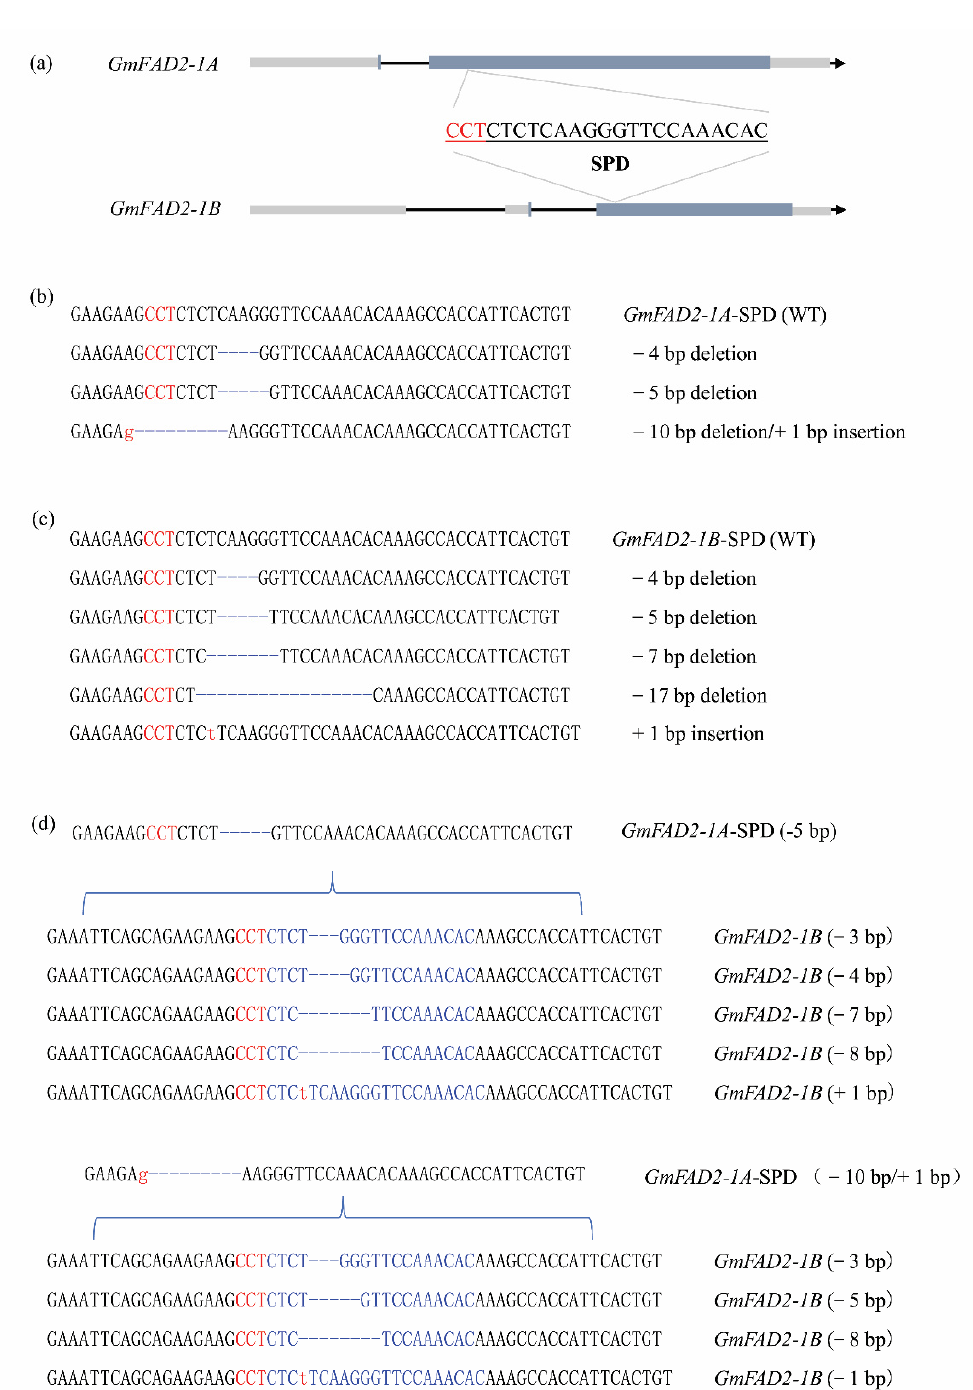
Figure 2. Three simultaneously obtained homozygous mutants of fad2-1a , fad2-1b , and fad2-1a / fad2- 1b using one target site. ( a ) Gene structures of GmFAD2-1A and GmFAD2-1B with the target sites of CRISPR/Cas9 indicated and schematic illustrating the target site sequence and corresponding PAM (red uppercase letters). ( b ) Sequencing results of the fad2-1a mutants. The types of indels are indi- cated in the right column. ( c ) Sequencing results of the fad2-1b mutants. ( d ) Sequencing results of the fad2-1a / fad2-1b mutants. Deletions and insertions are indicated as dashes and red lowercase let- ters, respectively.